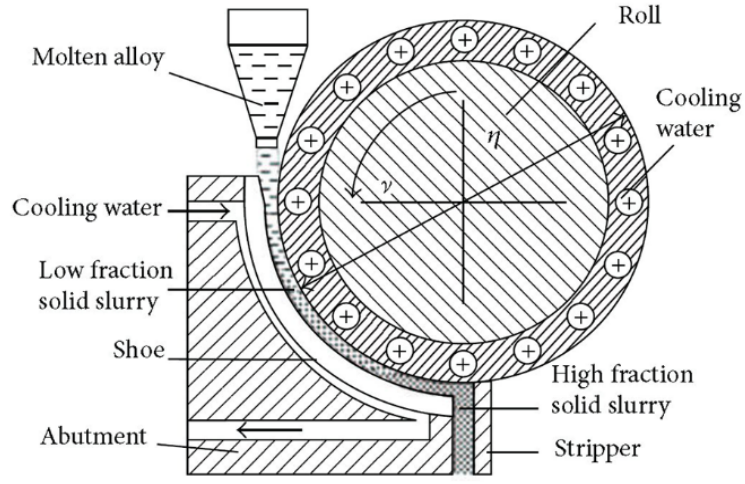
Figure 14. Schematic diagram of SCR process. Reprinted from [149] with permission from Elsevier. 3.12. Stress-Induced and Melt-Activated Process (SIMA) and Recrystallization and Partial Melting (RAP)